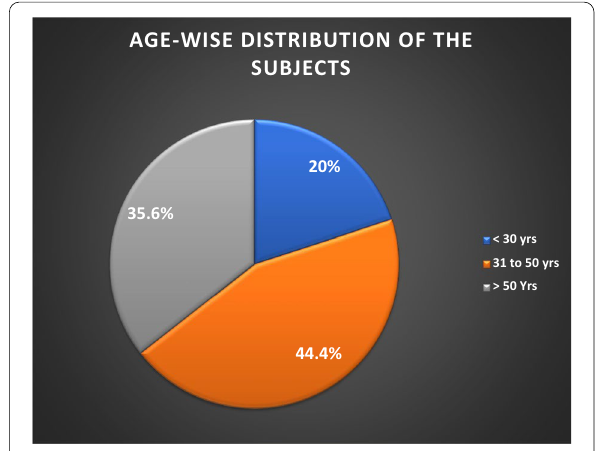
Fig. 1 Age-wise distribution of subjects